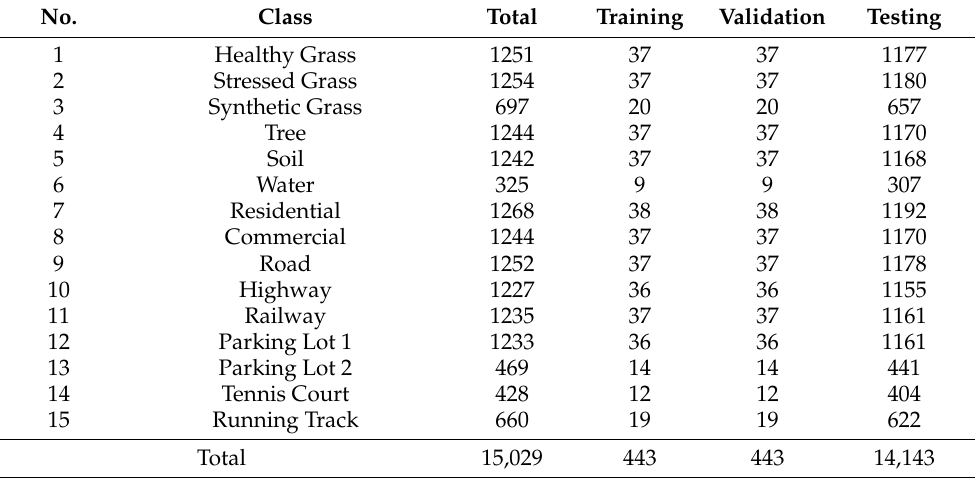
Table 3. Number of training, validation, and testing samples for the HOU dataset. No.